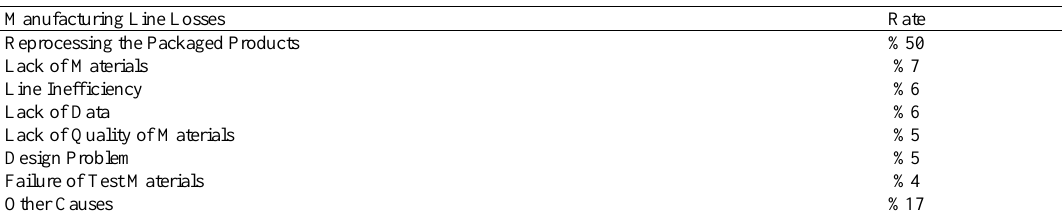
Table 6. The losses in the manufacturing